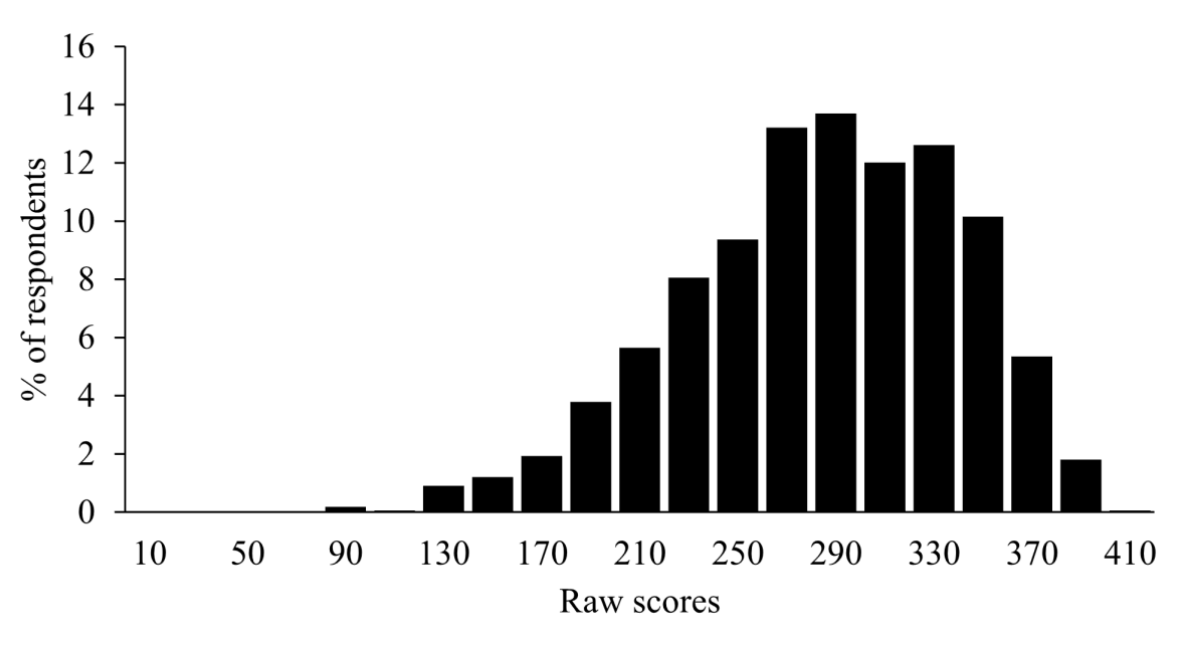
Figure 5. Distribution of raw scores depicting the percentage of respondents falling into different raw score brackets. Raw scores were calculated as the sum of spectrum question rating responses and reverse-scored problem question rating responses (ie, where 1 is converted to a 9 and vice versa to maintain a consistent positive-negative